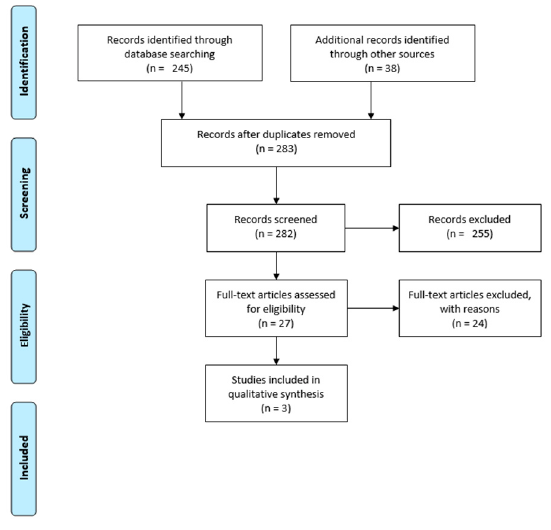
Figure A2. PRISMA 2009 Flow Diagram—Willingness [85]. For more information, visit www.prisma-statement.org.